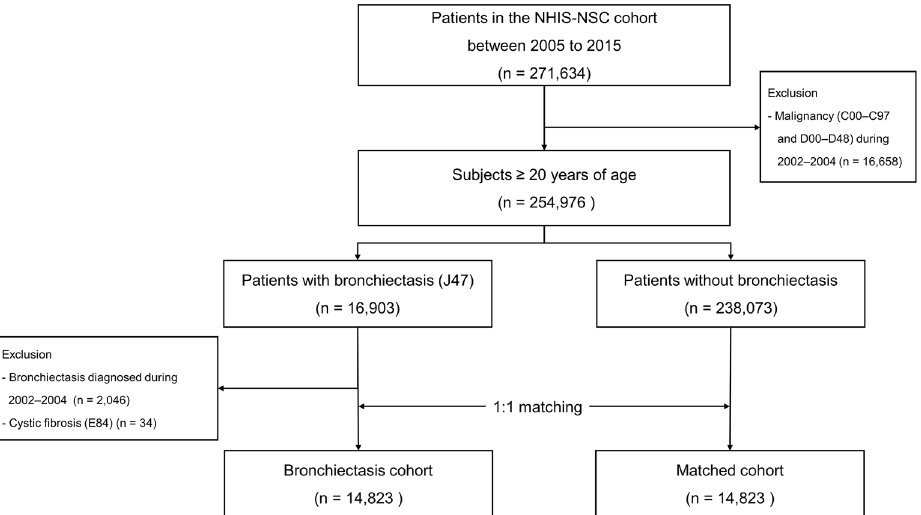
Figure 1. Flow chart of the study population. NHIS-NCS, National Health Insurance Service-National Sample